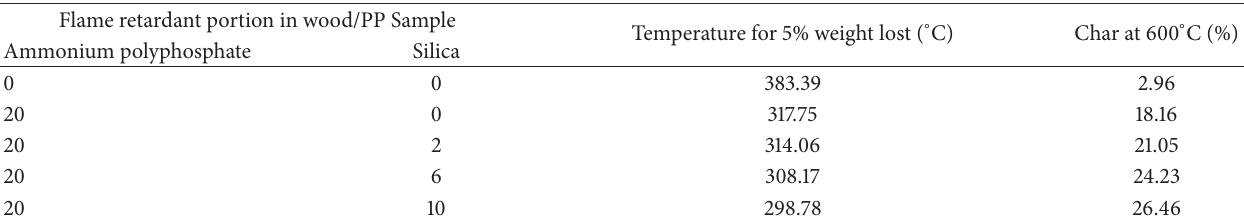
Table 6: TGA data of wood-fibre/PP composites